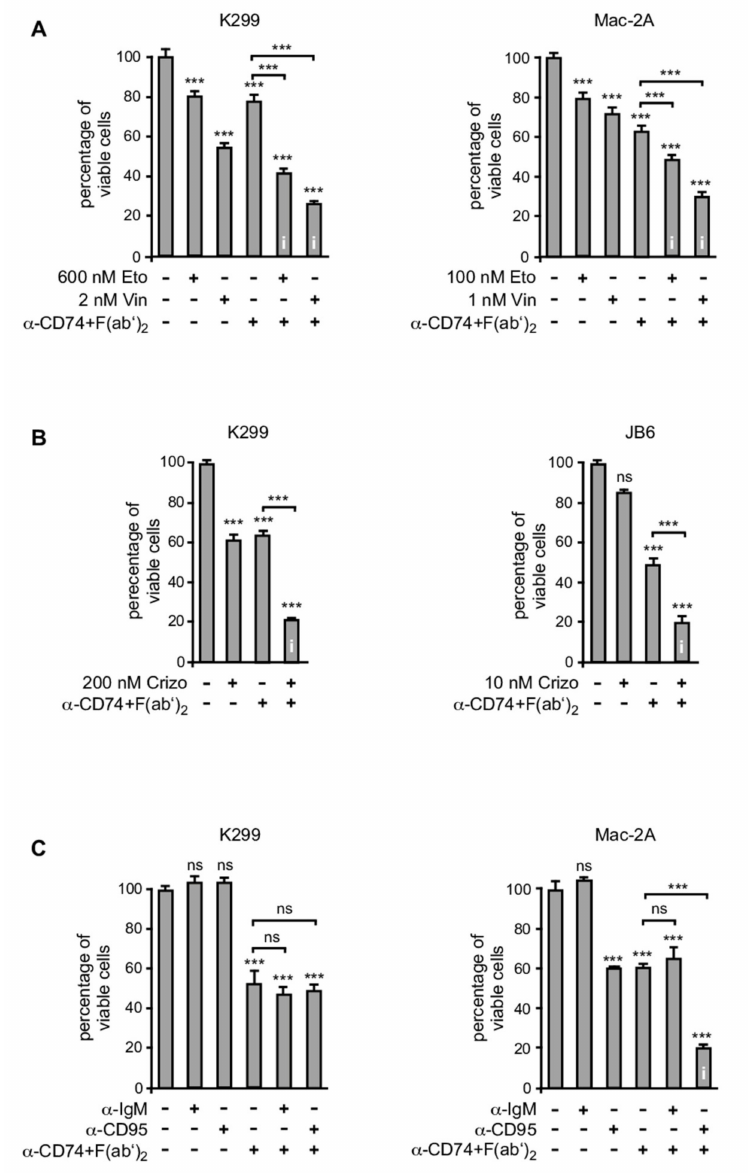
Figure 3. CD74 ligation sensitizes ALCL cell lines for various apoptosis-inducing stimuli. ( A ) In- creased induction of apoptosis following CD74 ligation in combination with conventional chemother- apeutics. K299 and Mac-2A cells were left untreated, or were treated for 48 h with etoposide (Eto), vincristine (Vin), anti-CD74 in combination with F(ab (cid:48) ) 2 ( α -CD74+F(ab (cid:48) ) 2 ; K299 with 2 µ g F(ab (cid:48) ) 2 and 0.5 µ g anti-CD74, Mac-2A with 8 µ g F(ab (cid:48) ) 2 and 2 µ g anti-CD74) or the respective combinations, as indicated. In all panels of this figure, the percentage of viable cells (Annexin V-FITC and PI double negative) is shown following Annexin V-FITC/PI staining and flow cytometry. Note that significant interaction effects (indicated by an ‘i’ in the respective columns) are observed in both cell lines by the combined treatment with chemotherapeutics and crosslinked α -CD74. ( B ) Increased induction of apoptosis following CD74 ligation and concomitant treatment with the ALK-inhibitor crizotinib. The ALK + cell lines K299 and JB6 were left untreated or were treated for 24 h (K299) or 48 h (JB6) with crizotinib (crizo), anti-CD74 in combination with F(ab (cid:48) ) 2 ( α -CD74+F(ab (cid:48) ) 2 ; K299 with 4 µ g F(ab (cid:48) ) 2 and 1 µ g anti-CD74, JB6 with 10 µ g F(ab (cid:48) ) 2 and 2.5 µ g anti-CD74), or crizotinib together with crosslinked anti-CD74, as indicated. Note that in both cell lines, significant interaction effects are observed by treatment with crizotinib in combination with crosslinked α -CD74. ( C ) Increased induction of apoptosis following CD74 ligation in combination with anti-CD95 in ALK – ALCL